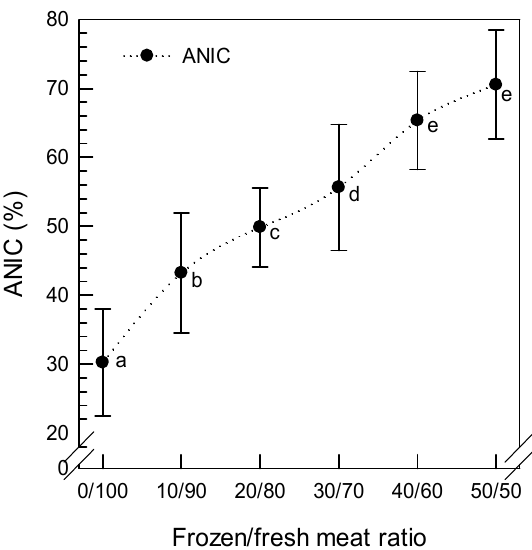
Figure 5. Amount of non ‐ intact cells (n = 32) (mean ± standard deviation) of minced meat with varying frozen to fresh meat ratios. Different letters indicate significant differences ( p < 0.05).